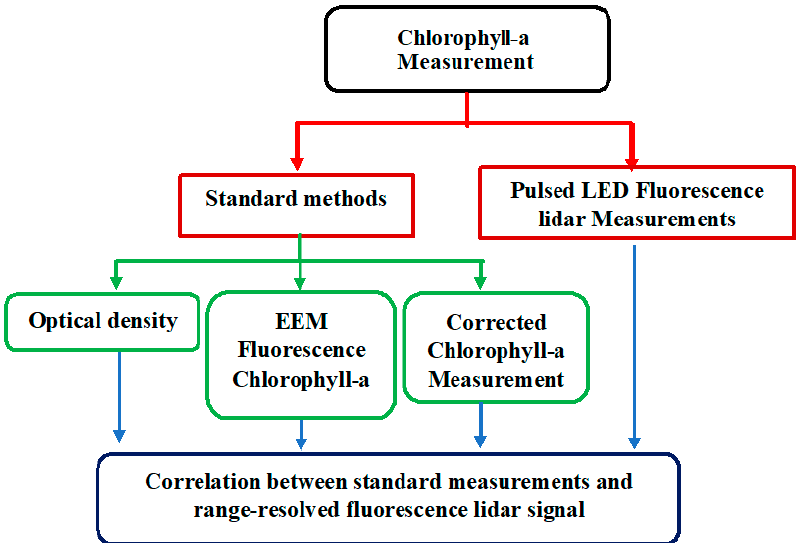
Figure 1. Chlorophyll-a measurements conducted using Spirulina concentration. The standard methods are optical density, EEM fluorescence chlorophyll-a analysis, and corrected chlorophyll-a measurements. These methods were correlated with the range-resolved fluorescence lidar signal. All measurements were observed at 680 nm for chlorophyll-a and 700 nm for turbidity measurements.